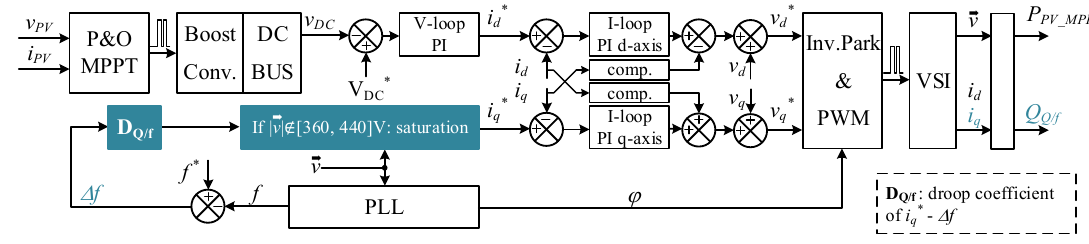
Figure 5. Control block diagram of the PV system.